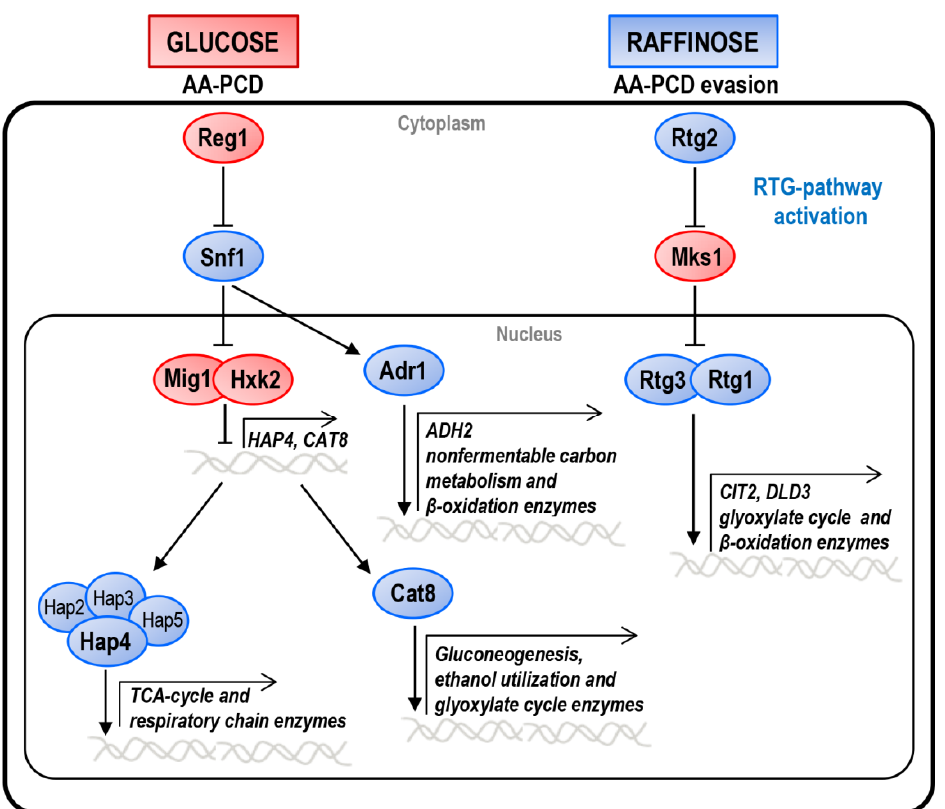
FIGURE 1: CCR and RTG pathway network. Schematic overview of the CCR and RTG pathways in yeast cells grow- ing either in glucose, in which cells undergo AA-PCD, or in raffinose, in which cells evade AA-PCD. For details see text. The factors regulating either pathway are indicated. Blue and red shapes indicate pro- teins active in raffinose or in glucose, respectively. Major genes whose transcription is controlled by each pathway are